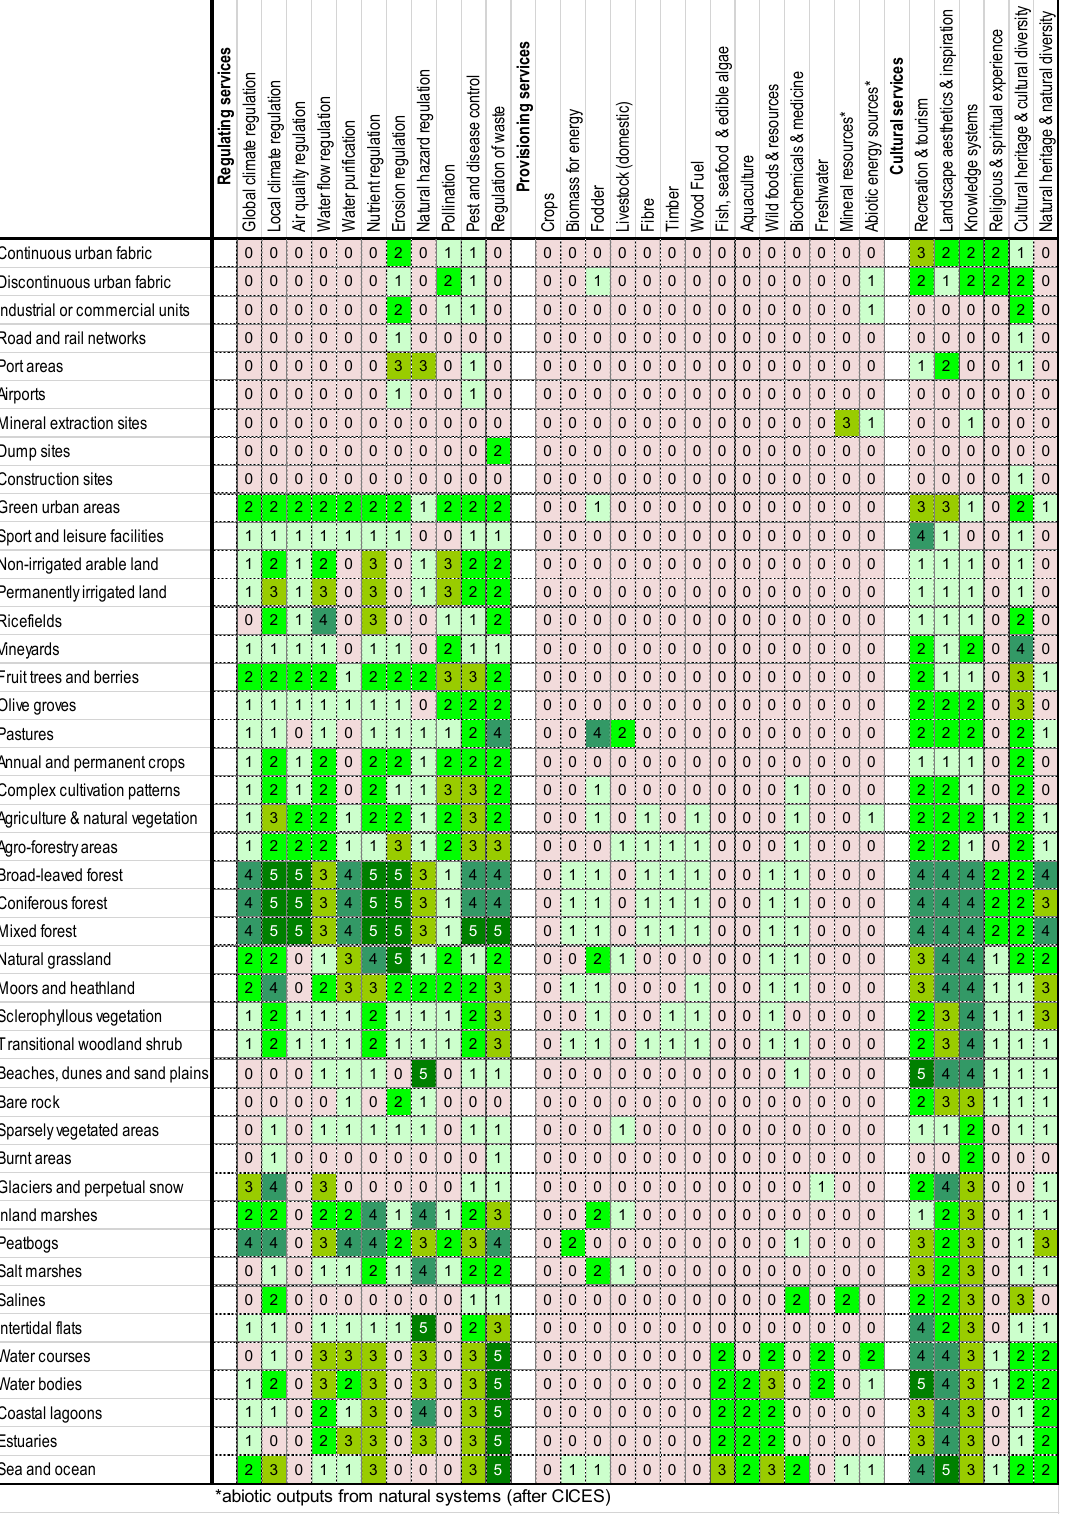
Figure 5: Exemplary ecosystem service flow matrix. The exemplary evaluation refers to a hypothetical European „normal“ landscape in summer (before the harvest period). Scale from 0/rosy = no relevant flow; 1/grey green = low relevant flow; 2/light green = relevant flow; 3/yellow green = medium relevant flow; 4/blue green = high relevant flow; and 5/dark green = very high (maximum) relevant flow (after Burkhard et al. 2009 and